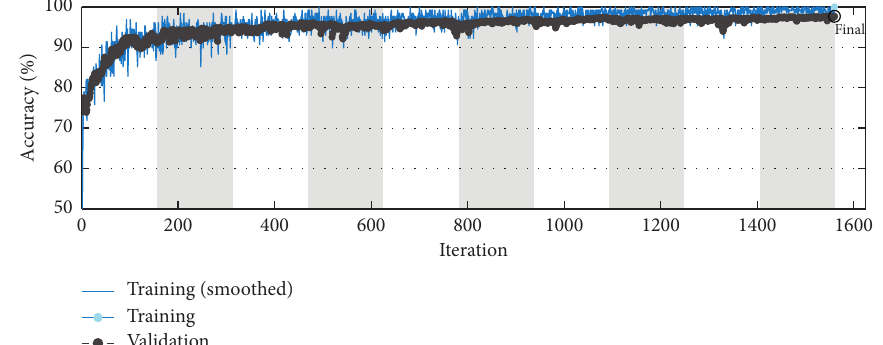
Figure 4: Evolution of accuracy during the training progress.